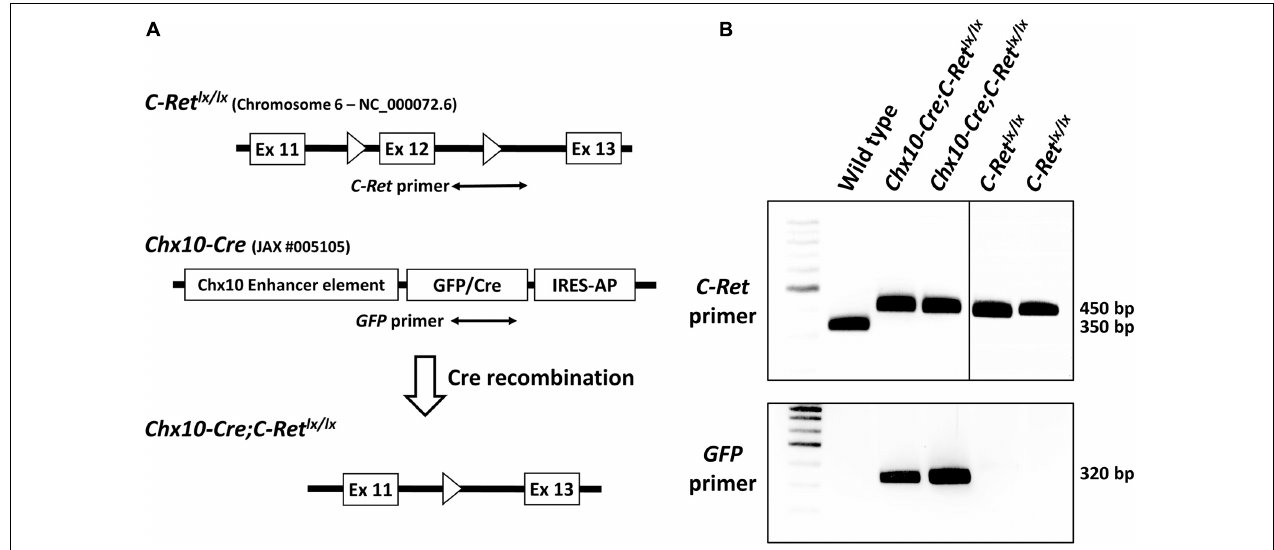
FIGURE 1 | Targeting strategy for the generation of conditional Ret -knockout mice and genotyping of C-Ret lx / lx and Chx10-Cre;C-Ret lx / lx mice using polymerase chain reaction (PCR). The Cre-loxP system was used to generate conditional Ret -knockout mice. In C-Ret lx / lx mice, the target, exon 12, of the C-Ret gene is flanked by two loxP sites ( A , top). The Chx10-Cre mouse model (JAX #005105) was generated by Chx10 BAC transgenes using a GFP/Cre translational fusion protein combined with internal ribosome entry sequence-human placental alkaline phosphatase cassette (IRES-AP) under the control of Chx10 enhancer elements ( A , middle). In Chx10-Cre;C-Ret lx / lx mice, Cre recognizes the loxP sites and excises the target exon 12 together with one loxP sequence while recombining the two ends of the remaining sequences, thus causing the permanent deletion of the target C-Ret gene. Exons are depicted as white boxes and loxP sites are shown as white triangles ( A , bottom). A PCR analysis of all three genotypes (wild-type, C-Ret lx / lx , and Chx10-Cre;C-Ret lx / lx ) using the C-Ret primers ( A , top) showed that a 350 bp signal was detected in the wild-type (WT) mice and 450 bp signals were observed in C-Ret lx / lx and Chx10-Cre;C-Ret lx / lx mice ( B , top). The PCR amplification of GFP ( A , middle), which was detected as a 320 bp fragment, was observed exclusively in Chx10-Cre;C-Ret lx / lx mice ( B ,